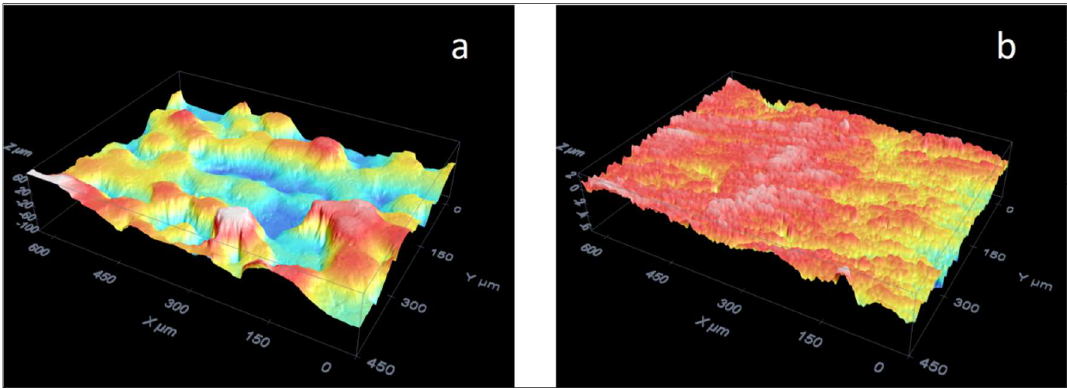
Figure 7. 3D surface reconstruction (specimens A): ( a ) Surface in the as-built condition; ( b ) Smoothed surface.